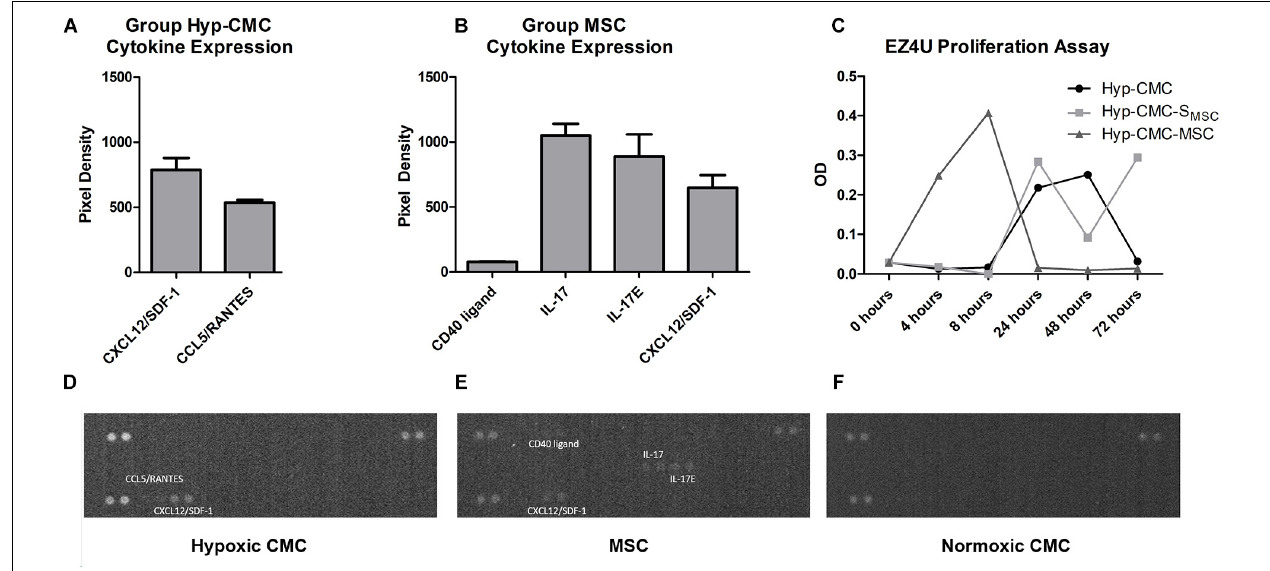
FIGURE 3 | Cytokine expression and EZ4U proliferation assay readout in unstimulated hypoxic and normoxic CMC and normoxic MSC. (A and D) Cytokine expression of Hyp-CMC secretome, showing detectable readout of CXCL12/SDF-1 and CCL5/RANTES. (B and E) Cytokine expression of normoxic MSC secretome, with detectable readout of CD40 ligand, IL-17, IL-17E, and CXCL12/SDF-1. (C) EZ4U proliferation assay of the control CMC and MSC and of the samples taken from each of the three experiment groups unstimulated hypoxic CMC (group Hyp-CMC), CMC stimulated with MSC secretome (group Hyp-CMC-S MSC ) and CMC stimulated directly with MSC (group Hyp-C-MSC) after the respective tested time period of 4, 8, 24, 48, and 72 h. (F) No detectable cytokine expression in normoxic CMC. MSC – Mesenchymal stem cells. CMC – cardiomyocytes. Hyp – hypoxic.